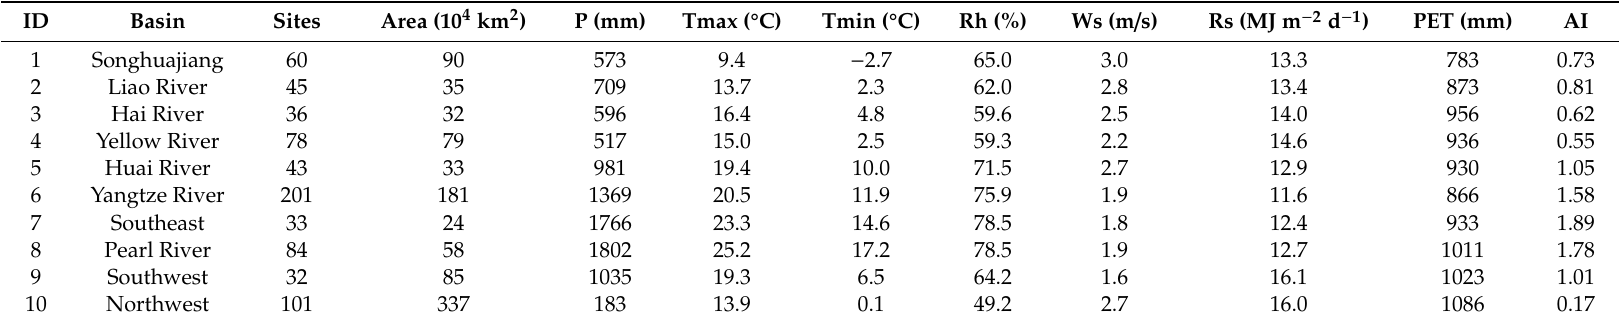
Table 2. Mean annual precipitation (P), maximum temperature (Tmax), minimum temperature (Tmin), relative humidity (Rh), wind speed (Ws), radiation (Rs), potential evapotranspiration (PET), and aridity (AI) in 1961–2016 in the ten first-level basins in